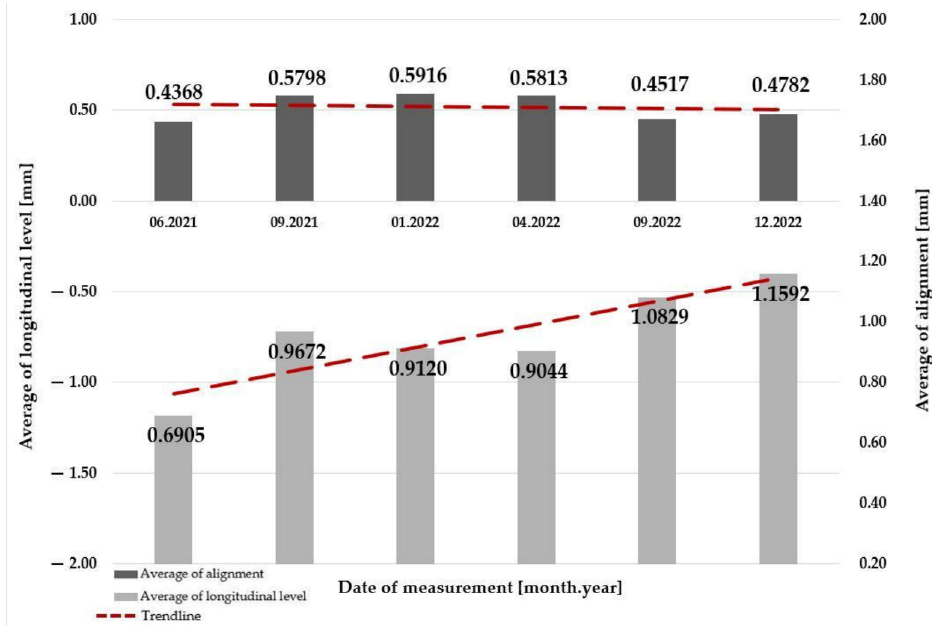
Figure 23. The change of average values of longitudinal level and alignment in Section